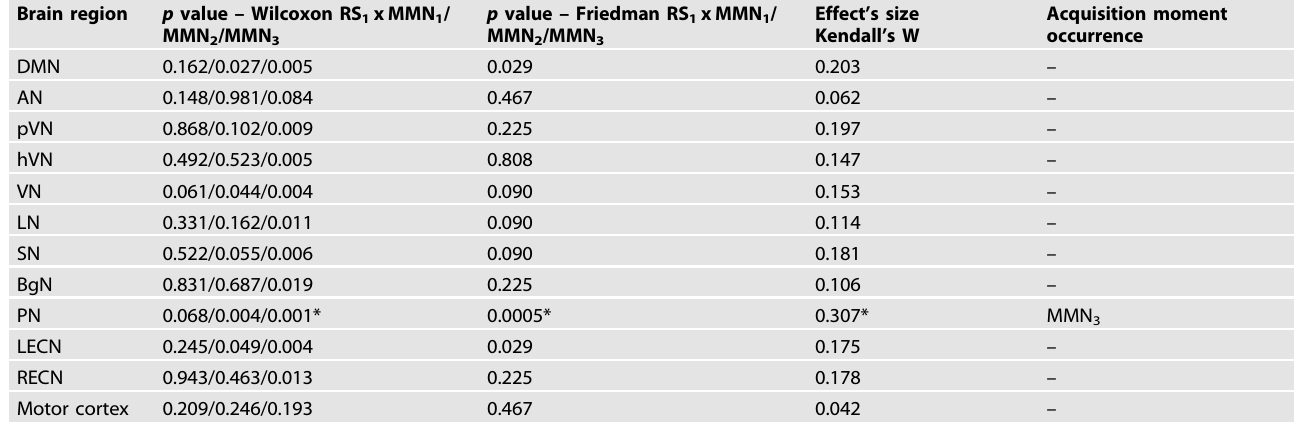
Table 3. Task effect results for functional brain regions analyzed with the Wilcoxon and Friedman tests and corrected using the Bonferroni method. Effect size was evaluated using Kendall ’ s W. Brain region